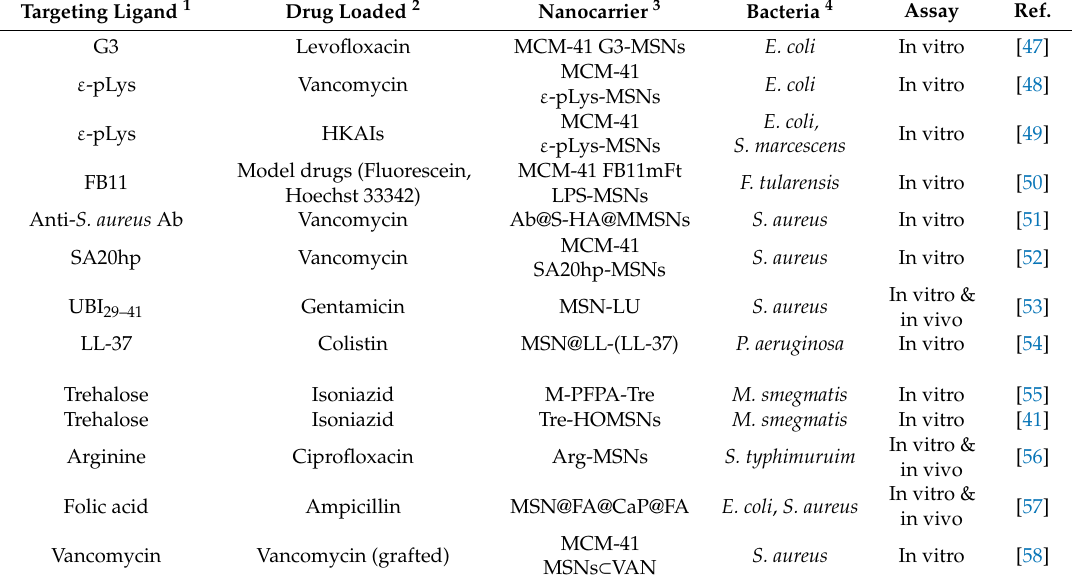
Table 1. Bacteria-targeted MSNs as antimicrobial delivery